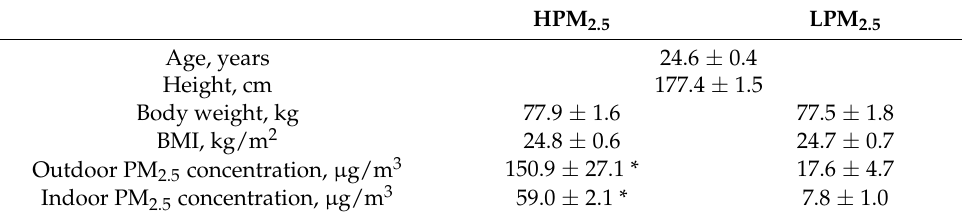
Table 1. Subject characteristics (n = 9) and PM 2.5 concentrations.